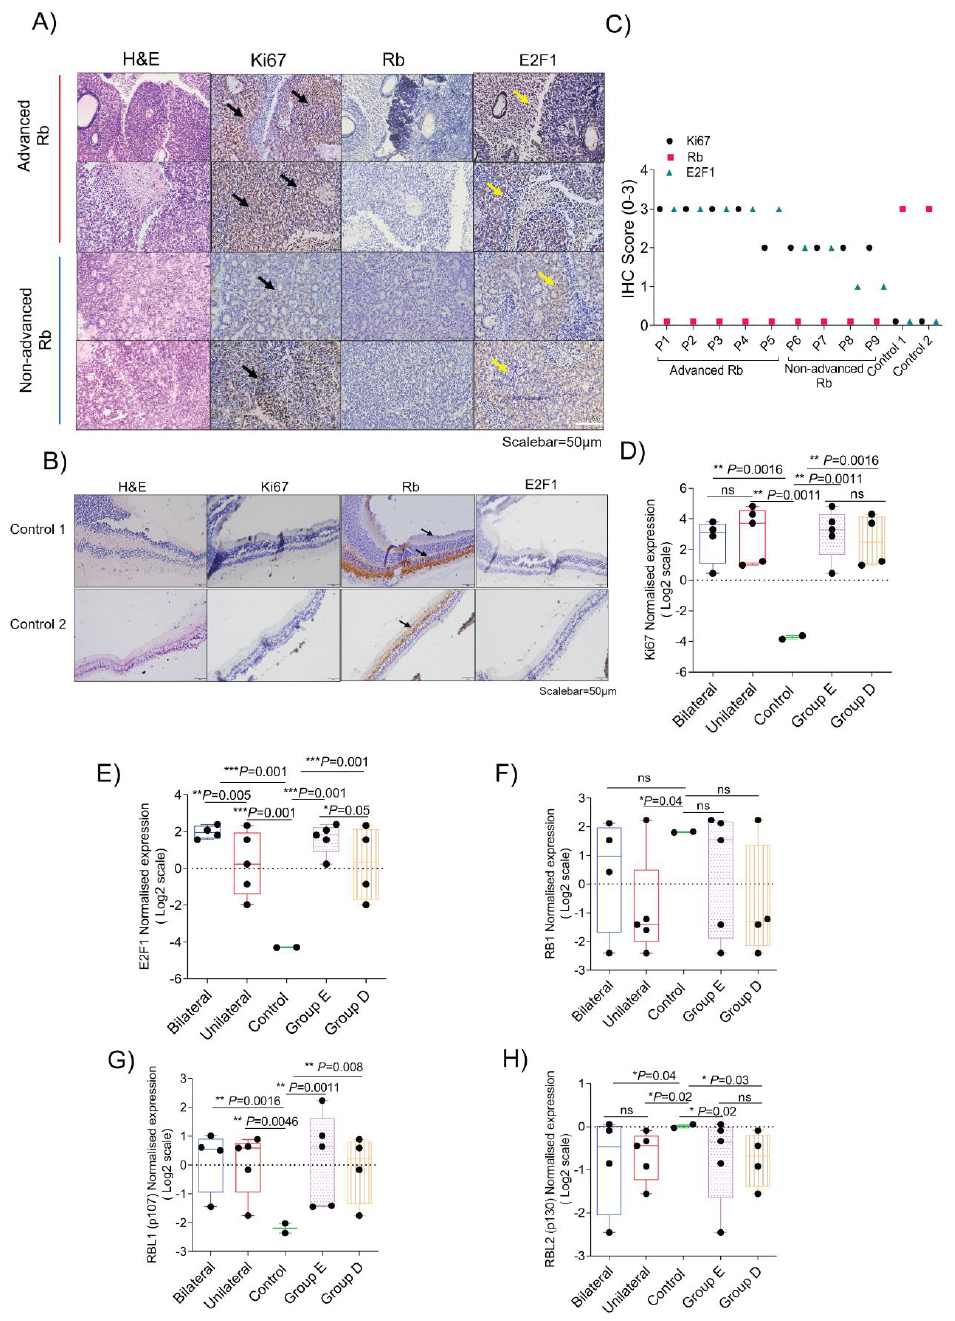
Figure 6. Molecular signatures specific to the clinical and histopathological grades of retinoblastoma in primary enucleated eyes. ( A ) H and E and immunohistochemistry profile showing the expression of Ki67, Rb, and E2F1 on 4 Rb tissues. High levels of expression for Ki67 and E2F1 were observed in the advanced Rb group, while expression of both proteins were lower in the non-advanced Rb group. Scalebar = 50 µm. ( B ) H and E and immunohistochemistry profile showing expression of Ki67, E2F1 on 2 pediatric retina tissues. Rb expression was high in pediatric control tissues while no E2F1 expression was observed. Scalebar = 50 µm. ( C ) IHC scores of Ki67, Rb, and E2F1 in 9 Rb tissues and 2 pediatric retina tissues. ( D ) Gene expression of Ki67 in bilateral, unilateral, Group E, and Group D identified in microarray compared to control. Ki67 expression was high in the Rb tumor